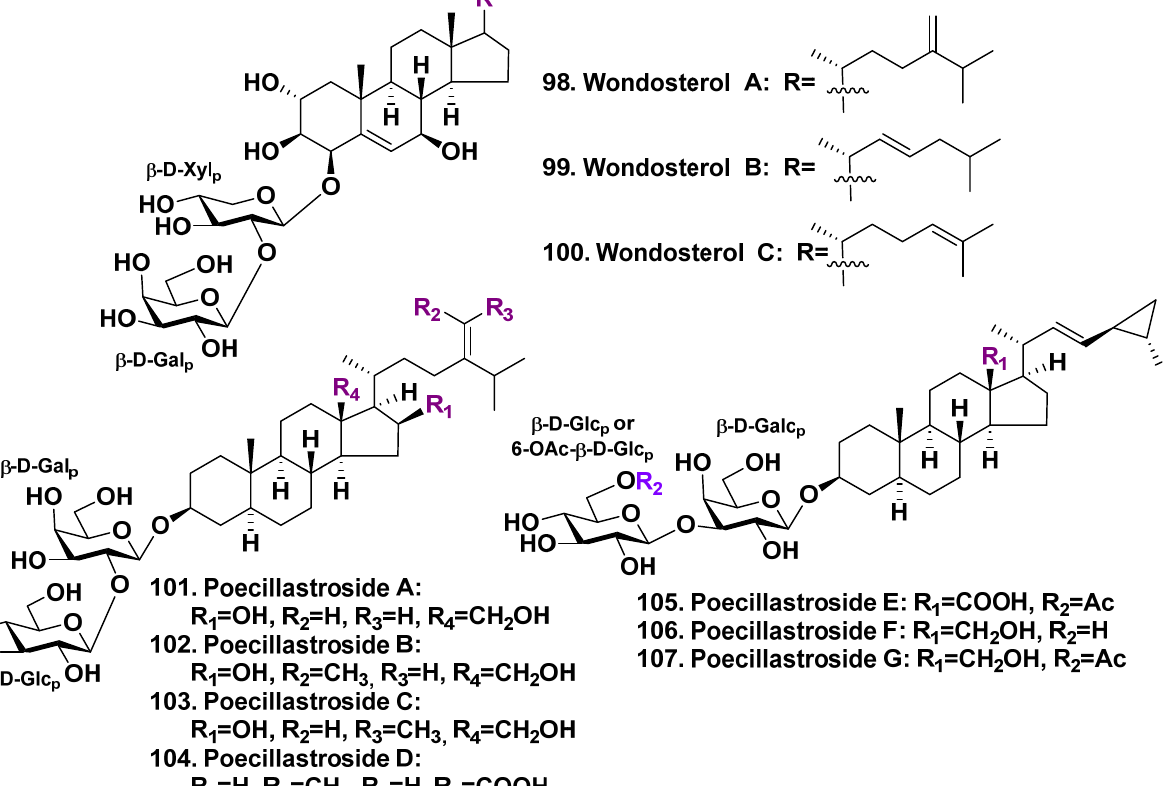
Figure 13. Wondosterols A–C ( 98 – 100 ) from a two ‐ sponge association and poecillastrosides A–G ( 101 – 107 ) from Poecillastra compressa .